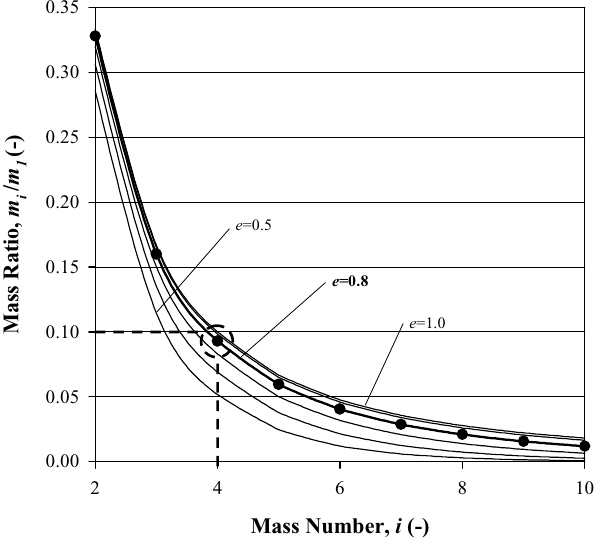
Fig. 12. Plot of mass ratio m i / m 1 versus mass number for varying coefficient of restitution in a vertically-stacked MET configuration. (-) means